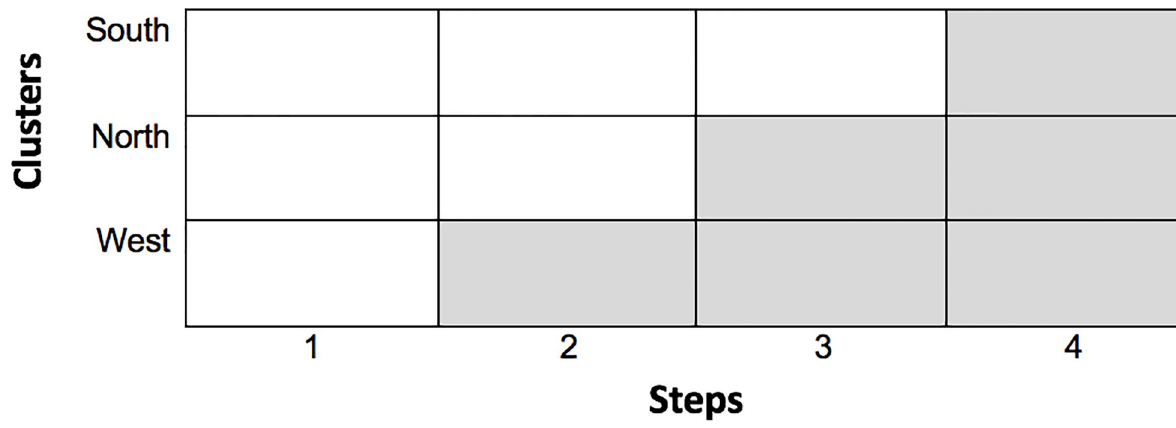
Fig 2. The stepped-wedge design for the